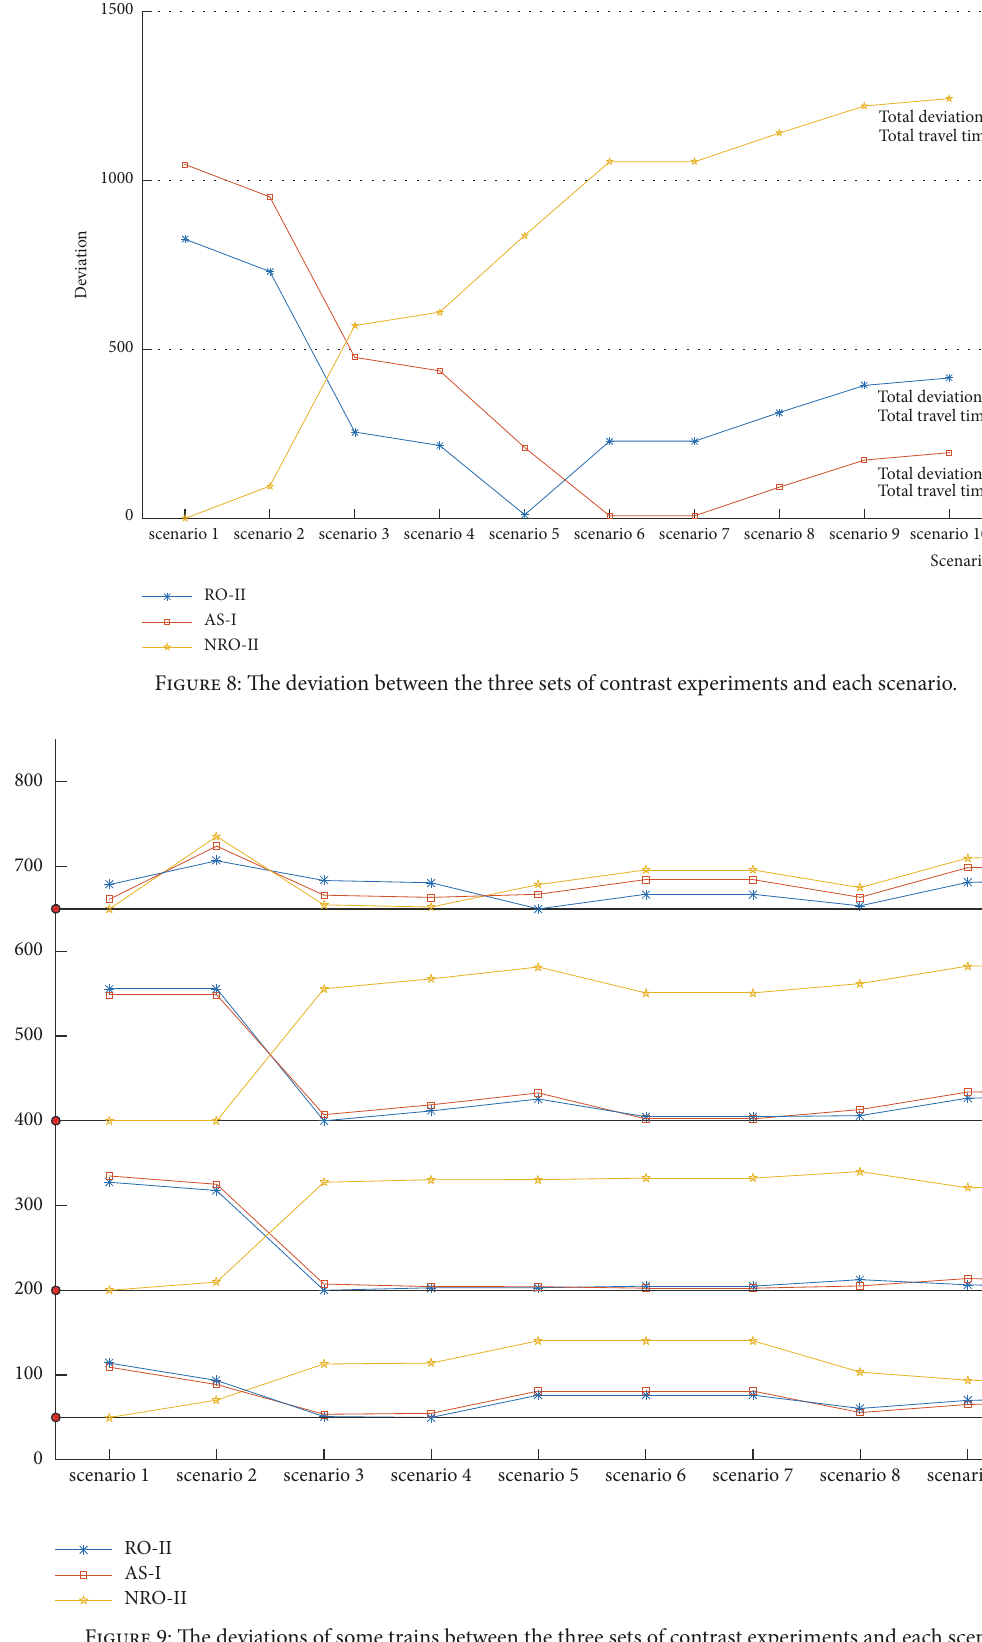
Figure 9: The deviations of some trains between the three sets of contrast experiments and each